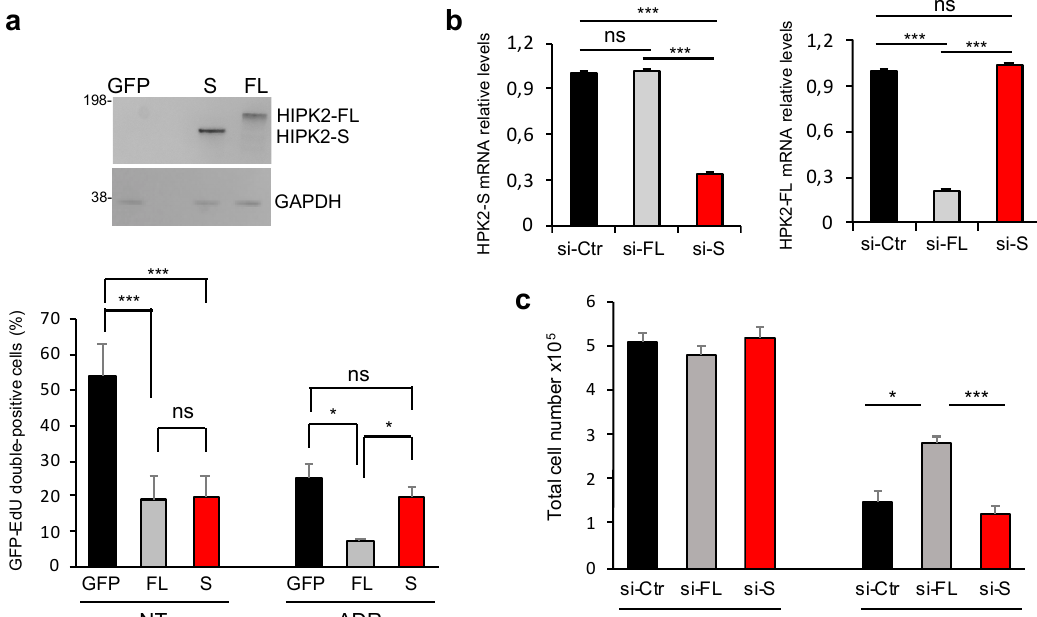
Figure 4. HIPK2-S isoform is dispensable for DNA damage response. ( a ) U2OS cells were transfected with expression vectors for the indicated GFP-tagged HIPK2 isoforms and analyzed by WB as in Figure 3a. Cells were maintained in nontreated (NT) condition or treated with 0.6 µ M ADR for 48 h (ADR). Inhibition of cell proliferation was assessed by EdU-incorporation and subsequent fluorescence. The percentage of EdU-positive cells was separately measured in at least 100 GFP-positive and 100 GFP-negative cells per dish. Transfected GFP-positive cells and nontransfected GFP-negative cells belong to the same dishes. Data represent the mean ± SD of three independent experiments. * p < 0.05; *** p < 0.001; ns p > 0.05. ( b ) U2OS cells were transfected with siRNAs specific for HIPK2-FL (si-FL 1 and 2, see Table 2) and HIPK2-S (si-S 1 and 2, see Table 2) or the universal negative control (si-Ctr) and analyzed 48 h post-transfection by qPCR to verify isoform-specific RNA interference. Histograms show data from one representative experiment out of four performed with two di ff erent siRNA mix (si-S1 / si-S2 and si-FL1 / si-FL2 or si-S3 / si-S4 and si-FL3 / si-FL4) and producing comparable results. ( c ) U2OS cells were transfected as in ( b ) and 48 h post-transfection cells were treated (ADR) or not (NT) with Adriamycin. Cell number was evaluated with an automated cell counter. Data represent the mean ± SD of three independent experiments. * p < 0.05; *** p < 0.001.